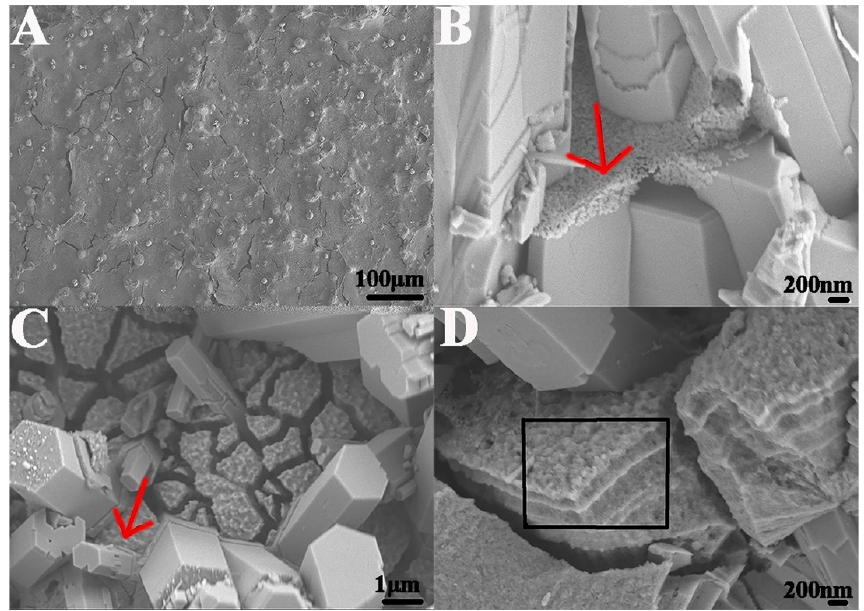
Figure 5. Scanning electron microscopy (SEM) evaluation of graphene oxide-hydroxyapatite (GO–HA) crystals treated with two cycles of mineralization and layer-by-layer deposition. ( A ) Image taken two days after remineralization. ( B ) Image taken three days after remineralization (the arrow represents the mineralized polyelectrolyte matrixes covered on the surface of the crystals). ( C , D ) Images taken four days after remineralization. The arrow in ( C ) represents the overgrowth of the original crystal, and the rectangle in ( D ) represents the mineralized polyelectrolyte matrixes in the voids among the crystals.